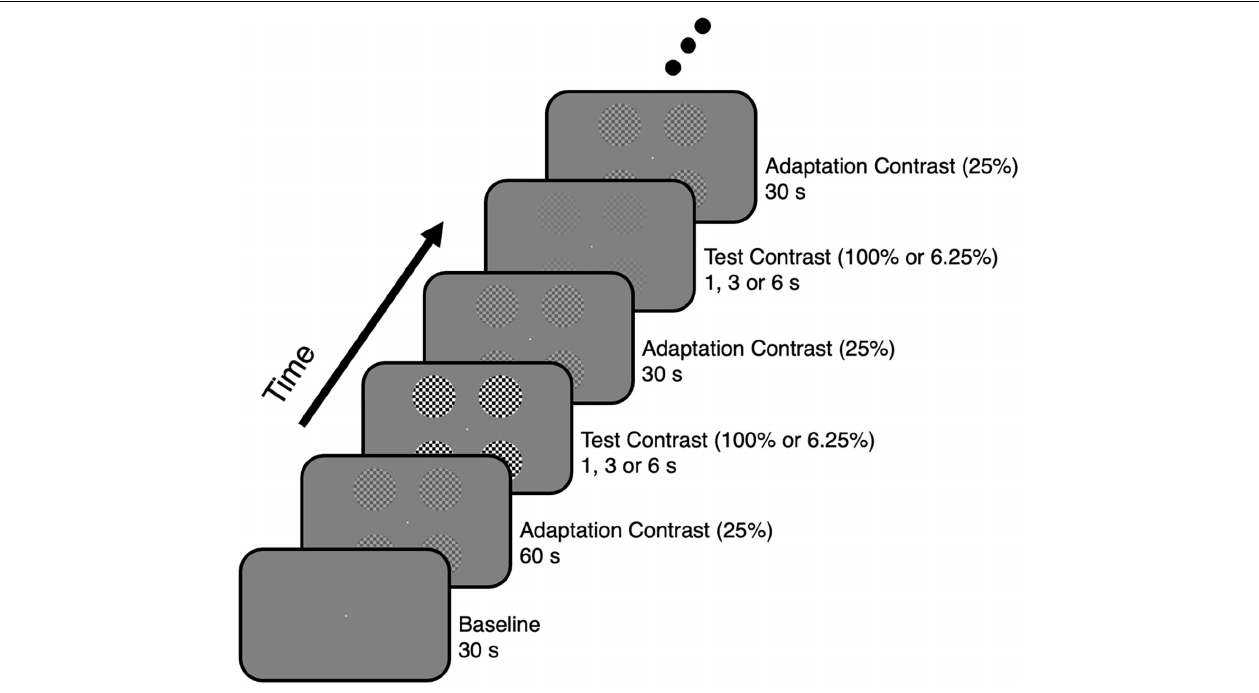
FIGURE 1 | Visual stimulus presentation paradigm for the contrast adaptation